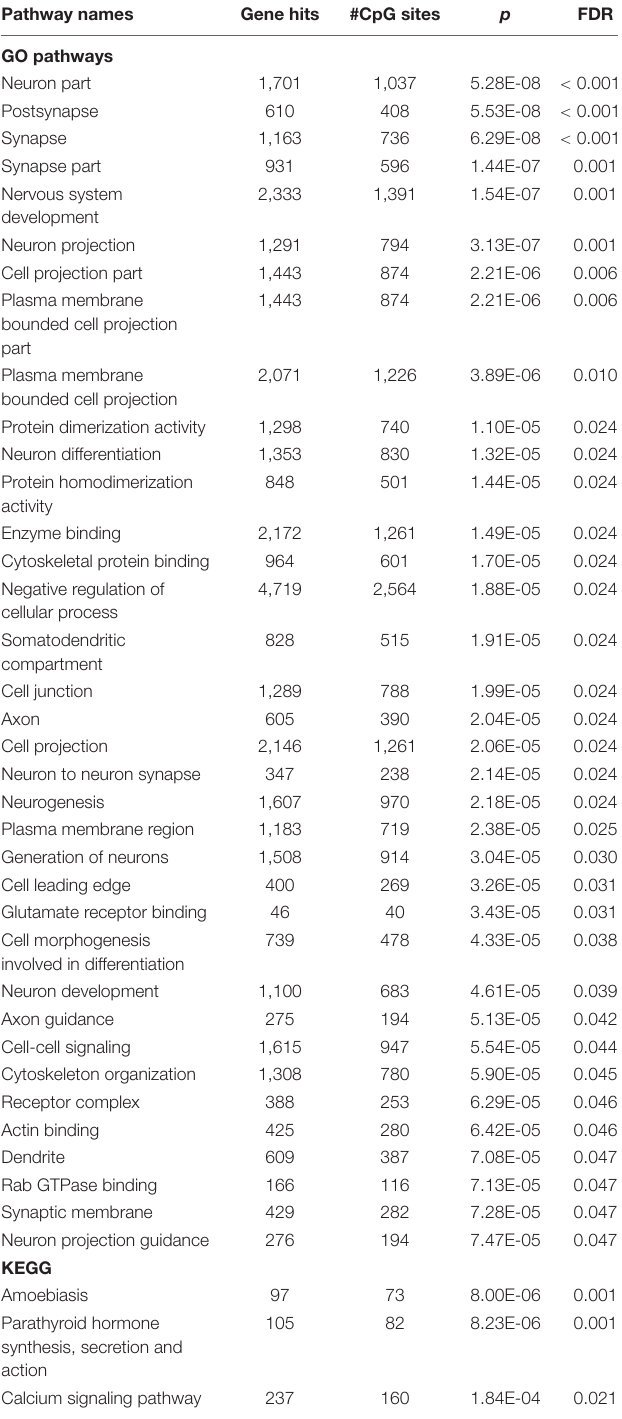
TABLE 3 | Pathway enriched by genes with CpG sites that differed between rapid cycling groups at p <